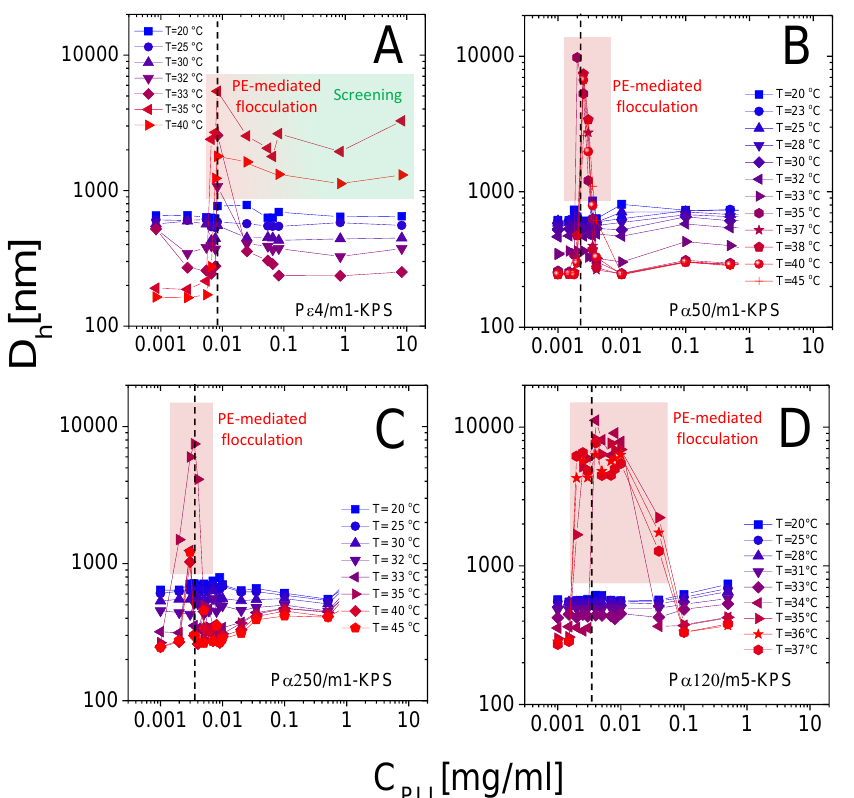
Figure 8. Hydrodynamic diameters in function of C PLL for P ε 4/m1-KPS (Panel A ), P α 50/m1-KPS (Panel B ), P α 250/m1-KPS (Panel C ) and P α 120/m5-KPS (Panel D ) mixtures, and selected tempera- tures as indicated in the panels. Points in the shaded regions refer to samples in which clustering at T > T c brought to the formation of macroscopic flocs. Vertical dashed lines corresponds to C IEP ( 40 ◦ C). Data in panel A are adapted from [32]-Published by The Royal Society of Chemistry (RSC) on behalf of the Centre National de la Recherche Scientifique (CNRS) and the